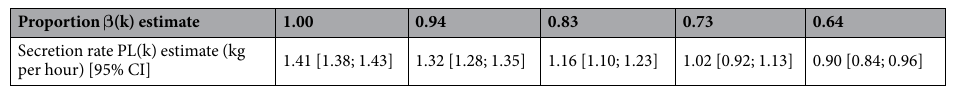
Proportion β (k) estimate